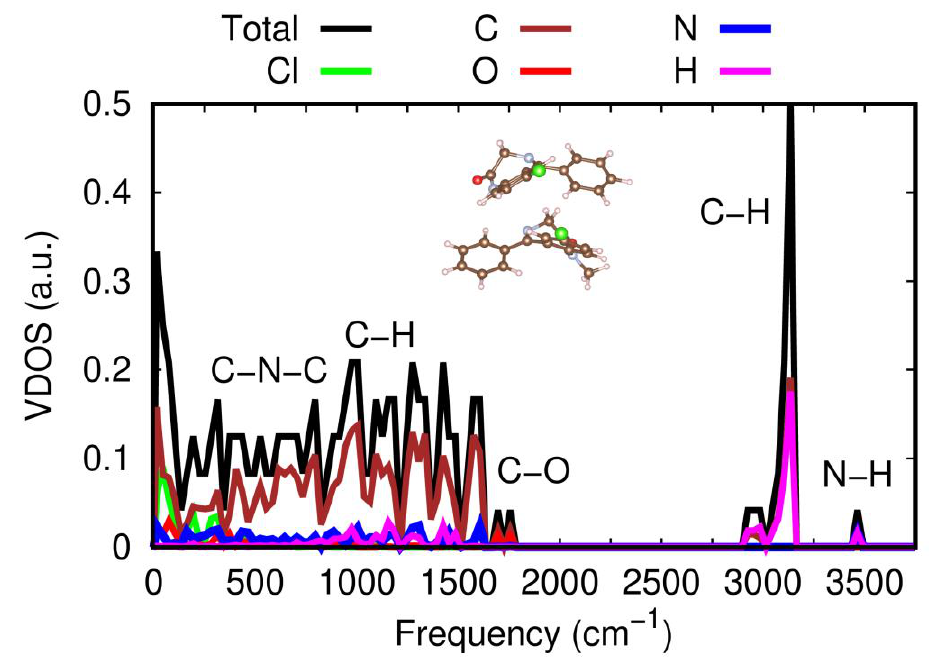
Figure 8. Vibrational density of states, VDOS, calculated with vdW-DFT methods for the energeti- cally most favorable heteromolecular dimer (“Configuration 1”, sketched in the figure). Total and atomic partial VDOS are represented in the figure. Different regions of the vibrational spectrum are highlighted in terms of the atomic species that dominate the corresponding dimer vibrations (that is, they present the largest partial VDOS).